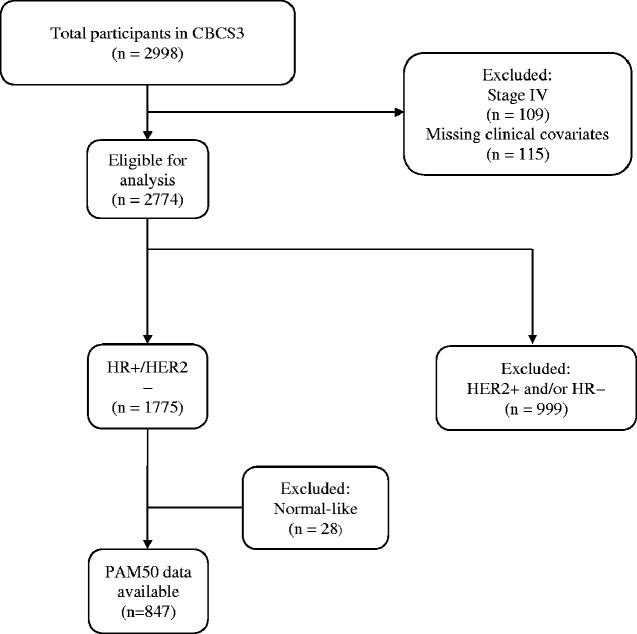
Flow diagram for study population. CBSC = Carolina Breast Cancer Study.